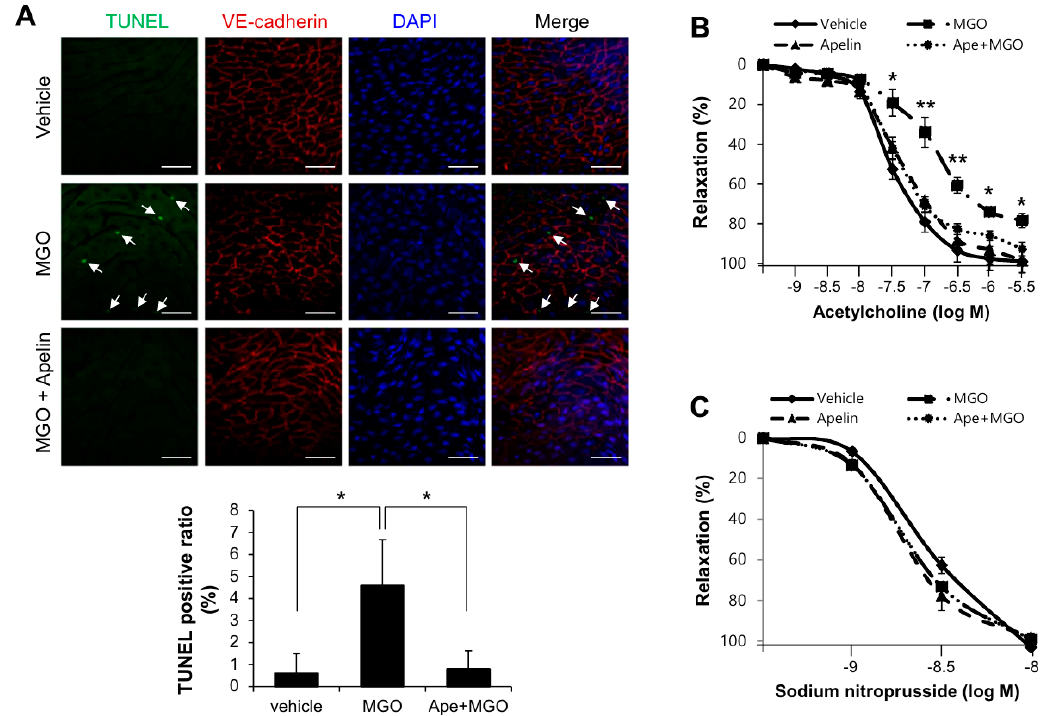
Figure 3. Apelin-13 protects aortic vessels from MGO-induced endothelial dysfunction. To determine the role of apelin-13 on MGO-induced cell apoptosis and endothelial dysfunction ex vivo, C57BL / 6 mice were anesthetized and aorta was isolated. ( A ) Aorta treated with MGO (100 µ M) for 24 h, with or without apelin-13 (1 µ M) pretreatment was stained with anti-VE-cadherin antibody for endothelial cell junction. Apoptosis was measured by TUNEL staining using the In Situ Cell Death Detection Kit (Roche, Indianapolis, IN) as described in the Materials and Methods section. Signals were observed under the confocal microscope ( × 400). Arrows indicate TUNEL positive cells which are apoptotic endothelial cells. Scale bars: 100 µ m. Quantification of apoptosis is shown as the percentage of TUNEL positive cells. More than 200 cells were counted for each category. Data represent means ± SDs. * p < 0.05 ( n = 5). ( B , C ) The e ff ect of acetylcholine on phenylephrine-induced vessel contraction in mouse aortic rings. ( B ) Mouse aortic rings were preincubated with phenylephrine (10 − 7 M) and then exposed to acetylcholine (10 − 9 –10 − 6 M). The results shown are representative of three independent experiments. * p < 0.05; ** p < 0.01 vs. MGO treated with apelin-13 group (Ape + MGO). ( C ) Dose-responses to sodium nitroprusside, nitric oxide donor, of phenylephrine-induced precontracted aortic rings. Results are